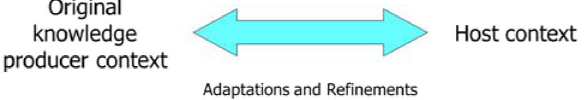
FIG. 1. Graphical representation of the basic adaptation and reinvention model [45].